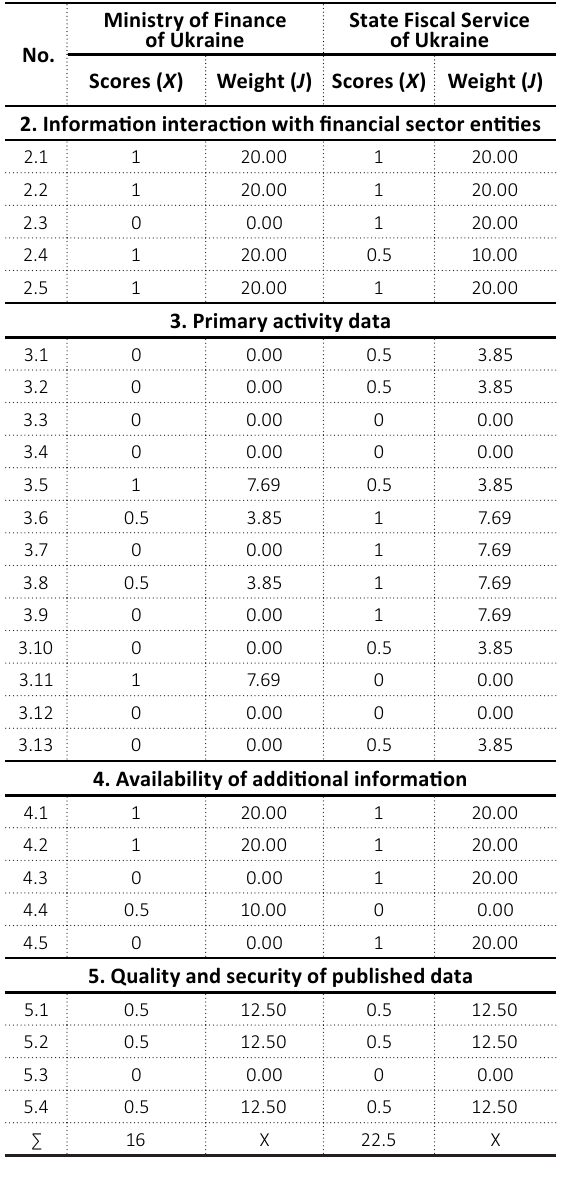
Table 6 (cont.). Output data for the calculation